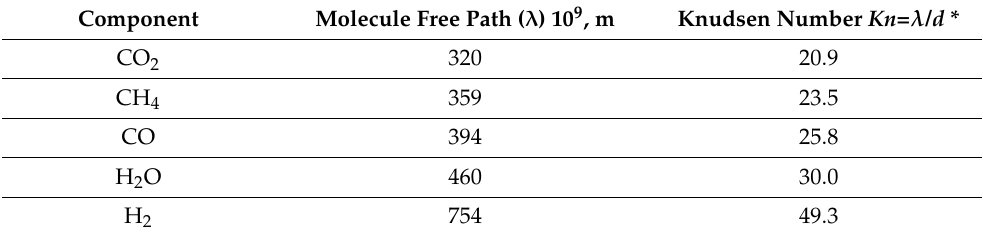
Table 4. The value of the Knudsen number at the temperature of 850 ◦ C for the components of the reaction mixture of DRM.